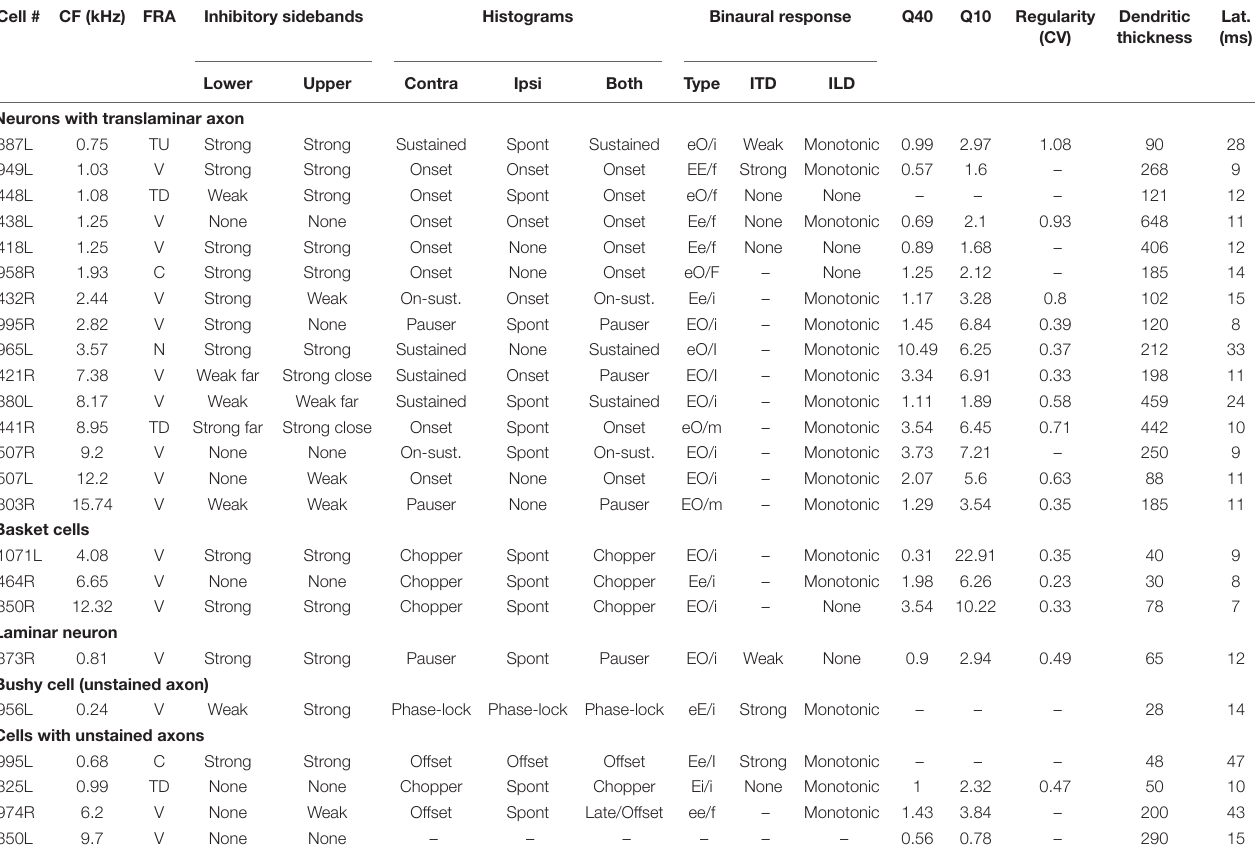
TABLE 2 | Physiological characteristics of the 24 filled cells arranged in 4 classes with the cells arranged by tonotopic order. Cell # CF (kHz) FRA Inhibitory sidebands Histograms Binaural response Q40 Dendritic